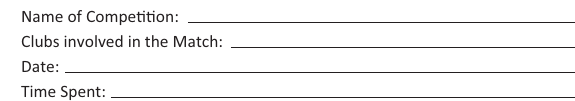
TABLE 1 -A2: Injury